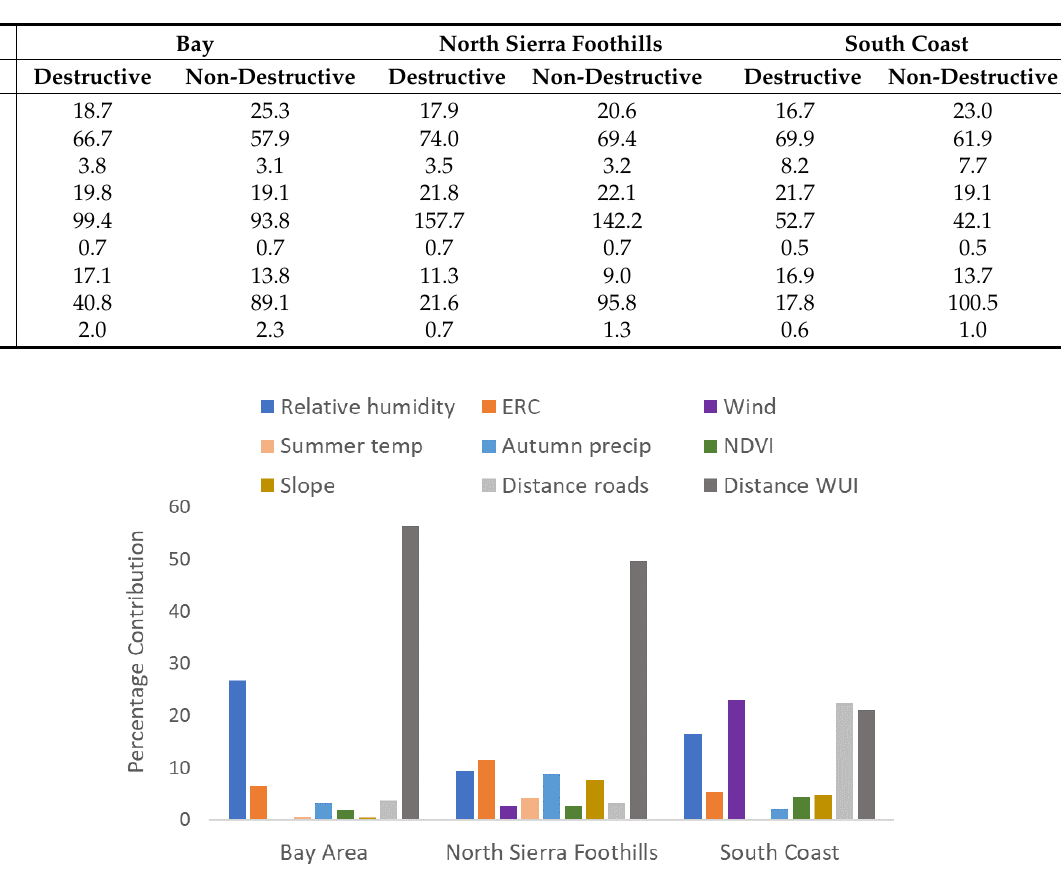
Table 3. Mean values for explanatory variables in models distinguishing destructive and non- destructive large wildfires in three California regions.